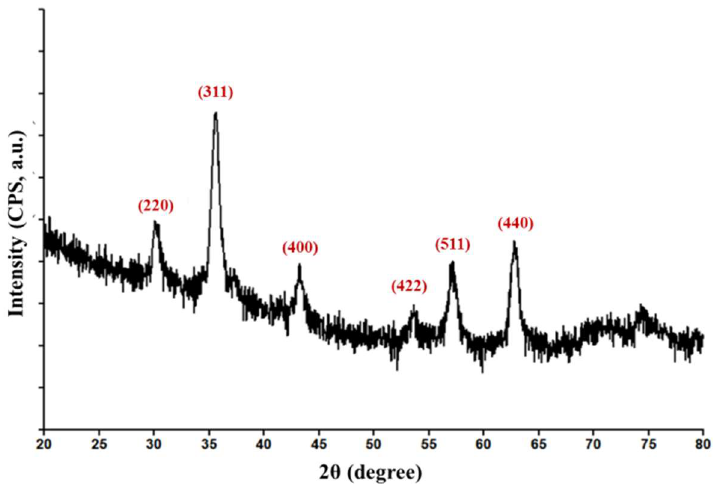
Figure 1. Diffractogram of Fe 3 O 4 @CEF powdery sample.